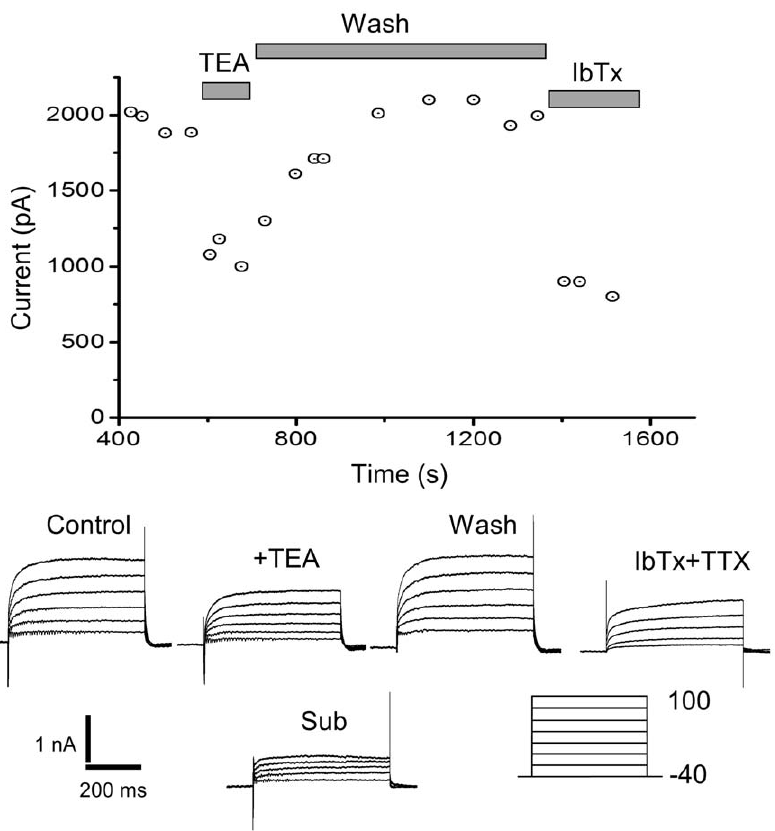
Figure 6. The TEA sensitivity of non-inactivating outward currents. A perforated whole-cell patch on a P7 neuron is sensitive to TEA and IbTx. Voltage protocol similar to the one in figure 5, indicated below the traces. The currents were monitored for 5 minutes before the perfusion of TEA (Control trace). Fast perfusion with 20 mM TEA causes a fast reversible block of the current (Traces marked + TEA). A wash slowly recovers the current to near control values (Marked wash). Application of IbTx (1 m M) causes an irreversible block of the current, similar to the block caused by TEA.